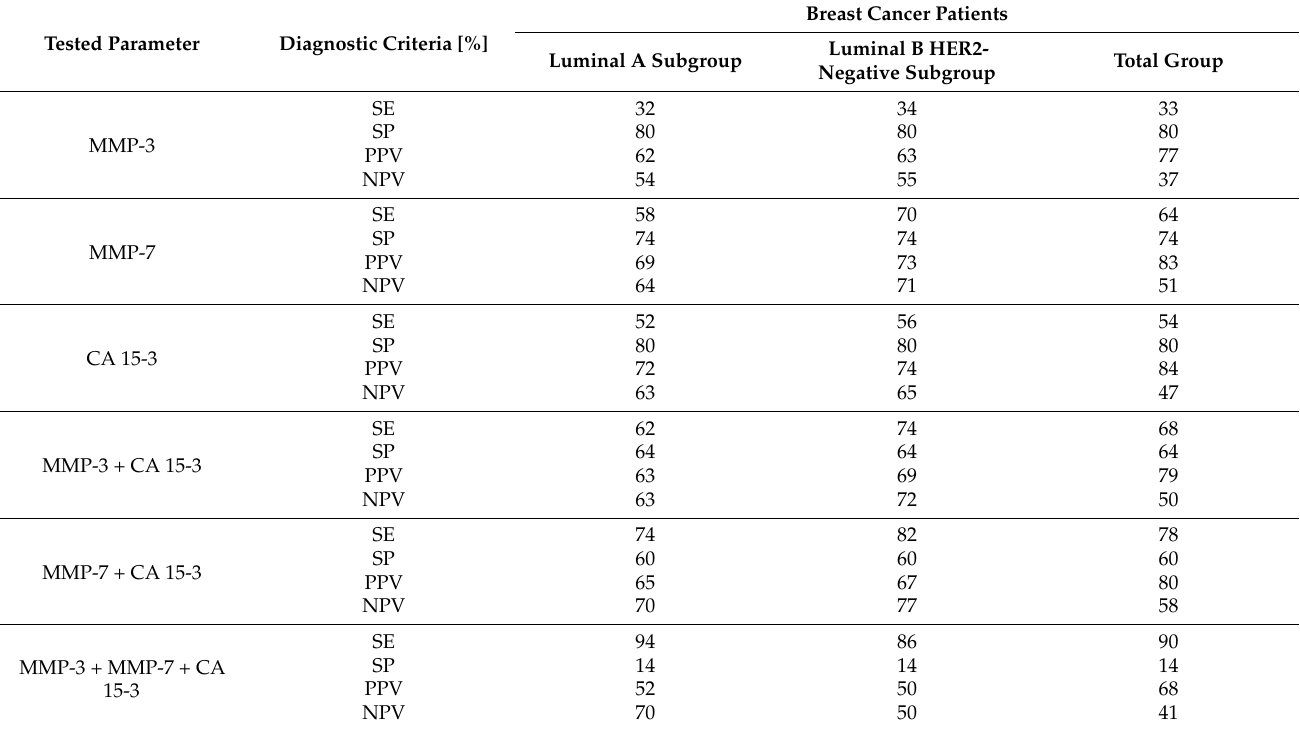
Table 5. Diagnostic criteria of tested parameters in patients with BC-total group and in selected